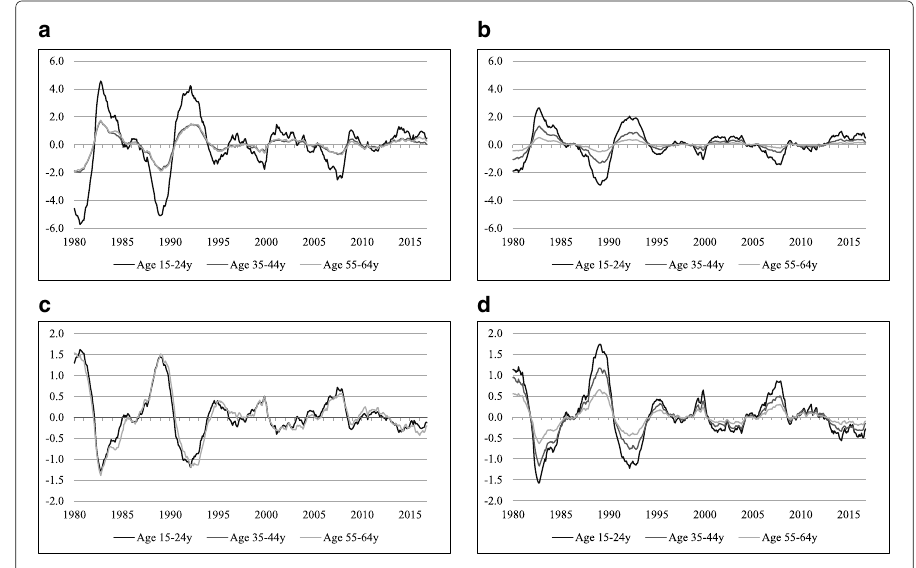
Fig. 3 Cycles by age bracket (youngest, middle, oldest). a Male unemployment cycle. b Female unemployment cycle. c Male participation rate cycle. d Female participation rate